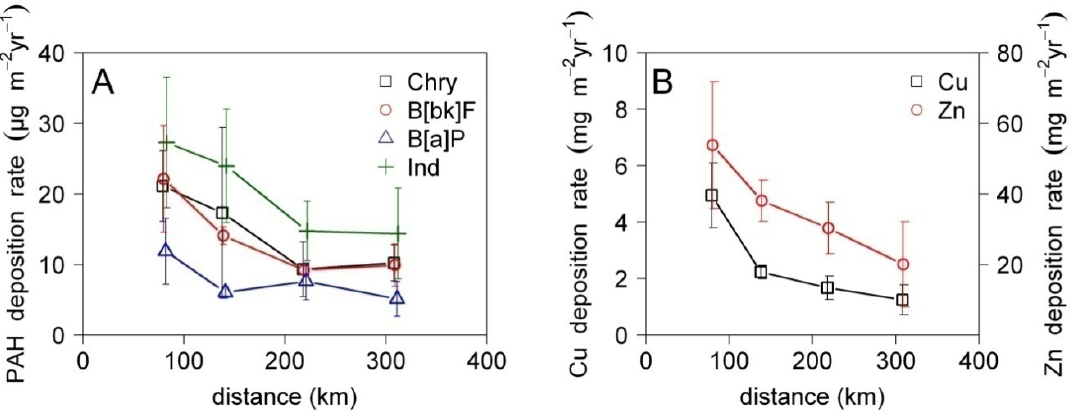
Figure 2. Average maximum deposition rates of ( A ) PAHs and ( B ) metals as a function of distance from the Greater Sudbury source area. The error bars represent the standard deviation of the three replicate peat